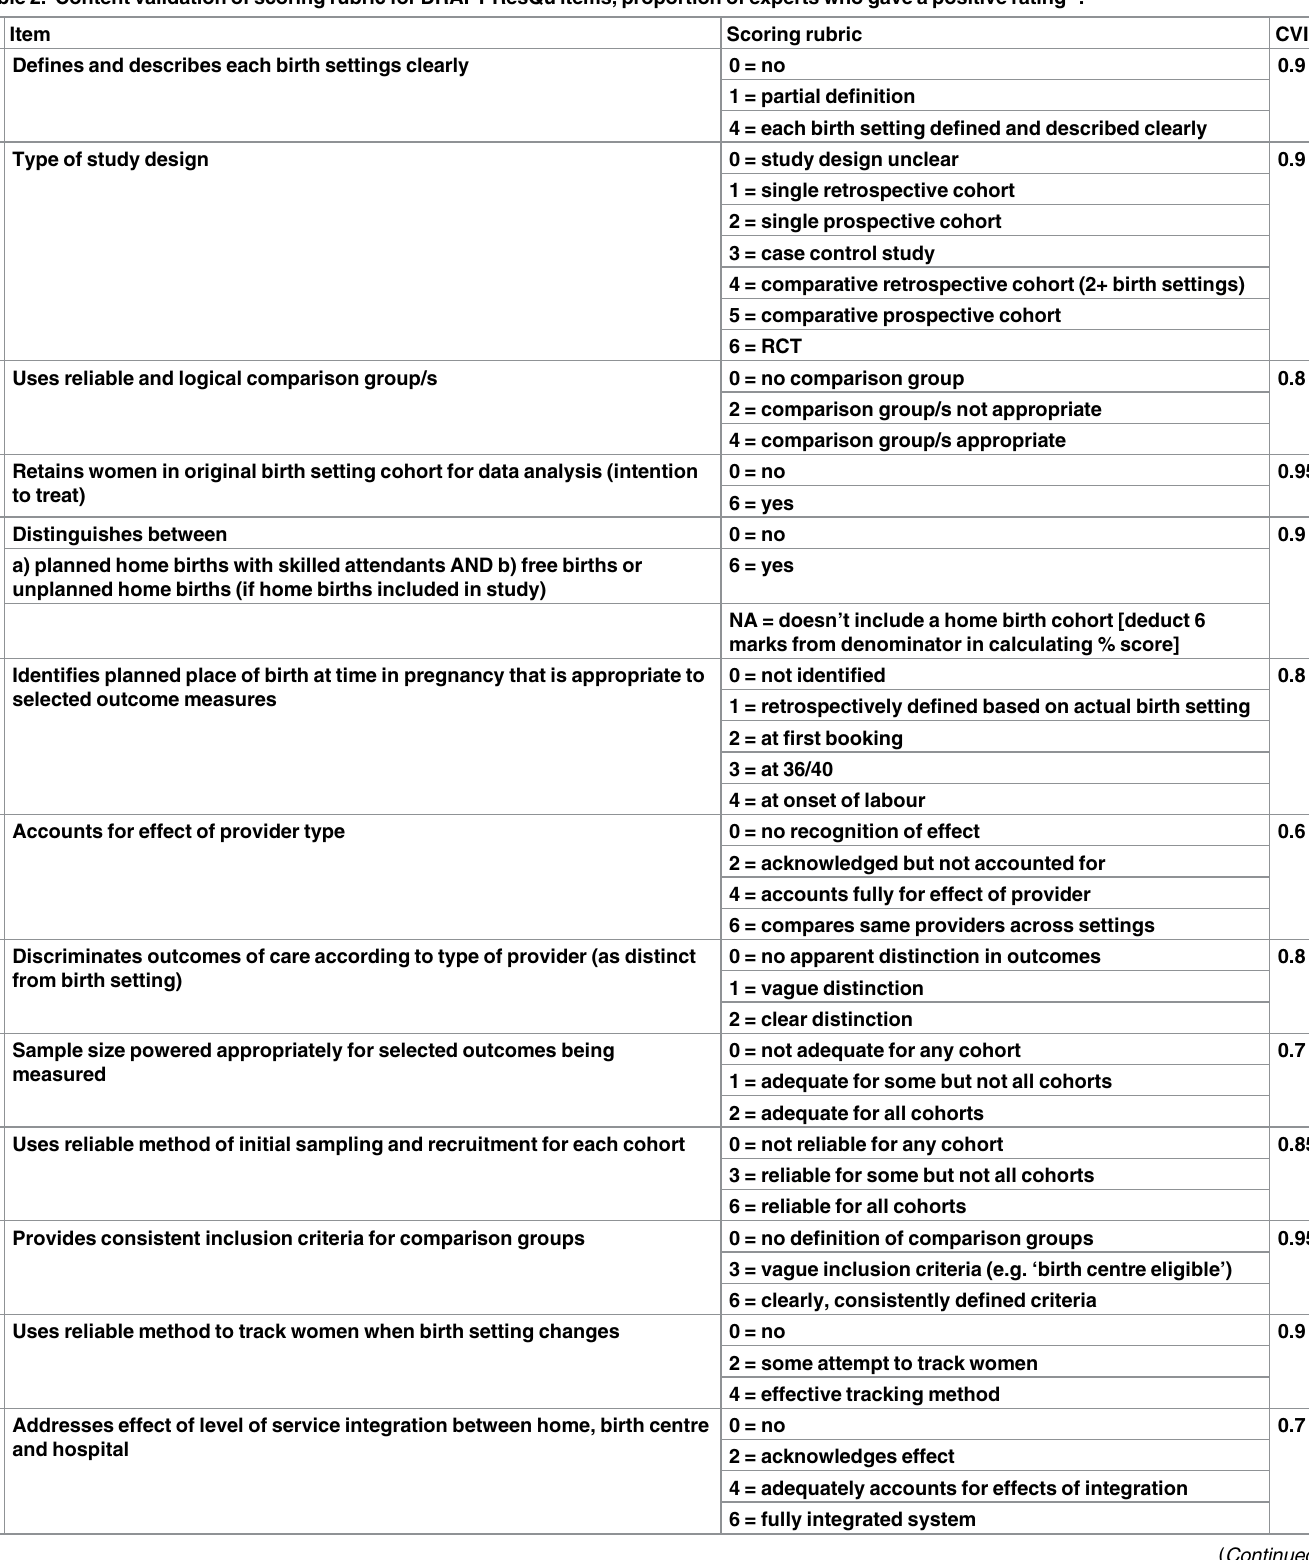
Table 2. Content validation of scoring rubric for DRAFT ResQu items, proportion of expertswho gave a positive rating * . Item Scoring rubric CVI 1 Defines and describes each birth settings clearly 0 = no